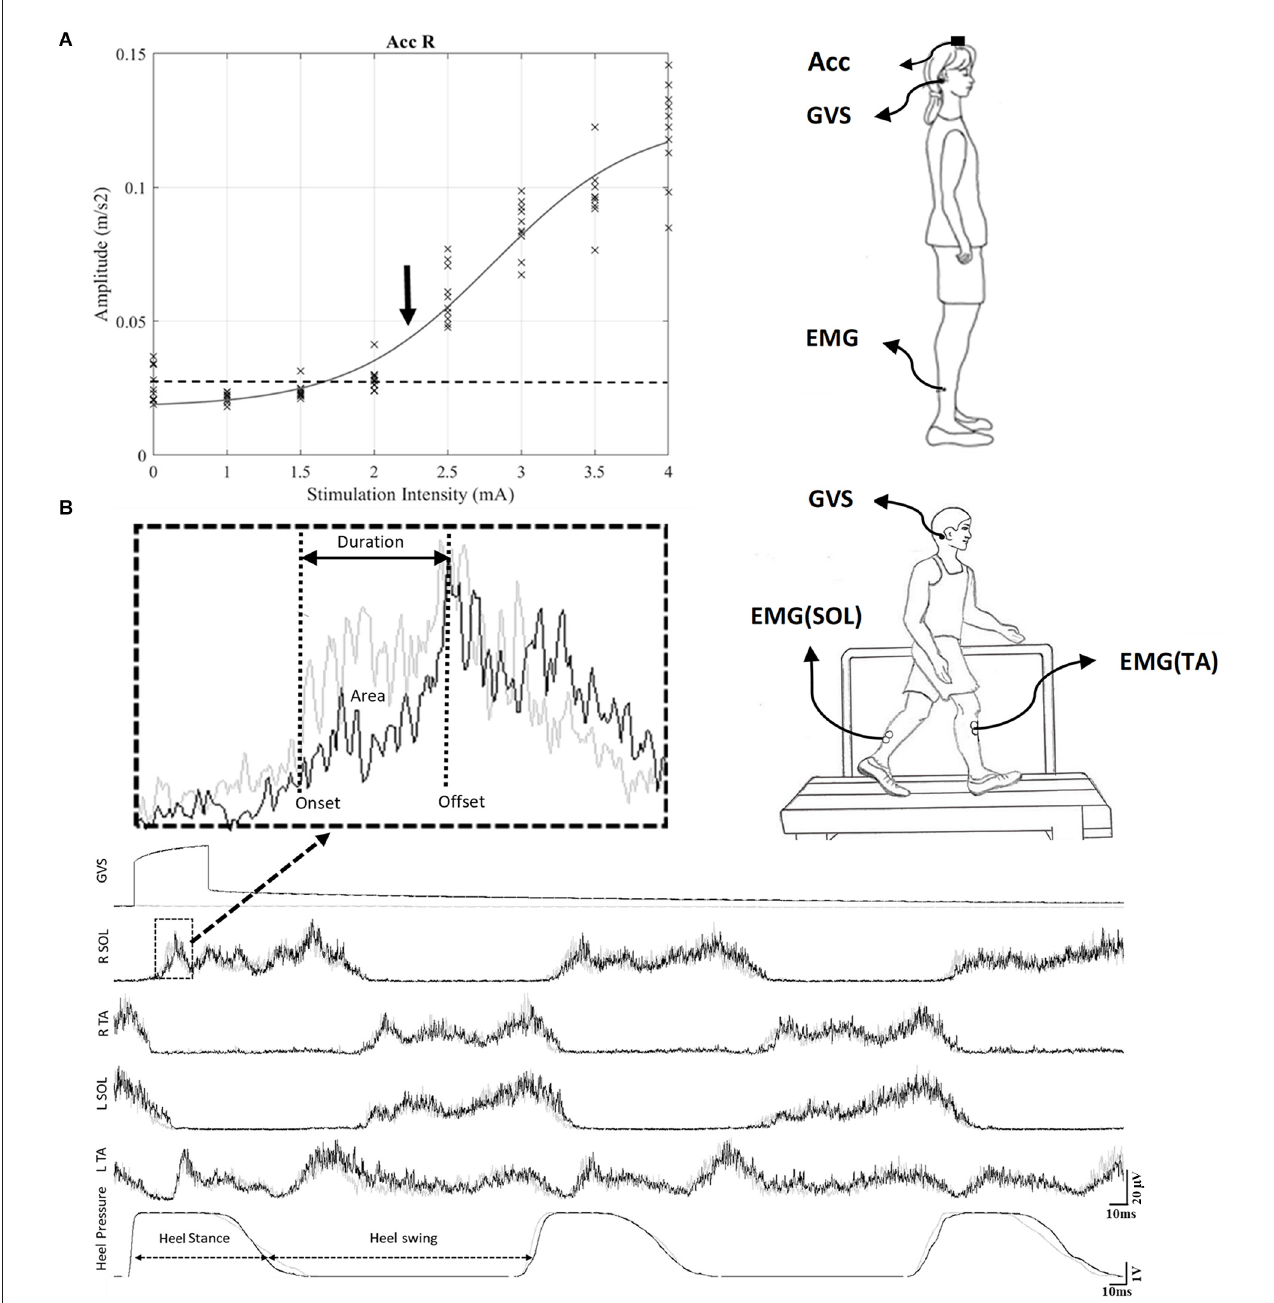
FIGURE1 (A) Recruitment curve set-up during standing. To determine the intensity of stimulation, a recruitment curve was constructed to identify the motor threshold (T) to GVS (see Section “Methods”). The threshold was based on the signal from an accelerometer placed on top of the head (vertex) while subjects were standing with eyes closed. For this representative participant, the threshold was 2.3 mA. (B) GVS during gait on the treadmill set-up: The black trace shows the EMG pattern during the stimulated cycle, and the gray trace shows the EMG pattern during the control cycle. A typical GVS response is shown in the medallion and measures of onset, offset and area are indicated. GVS, galvanic vestibular stimulation; EMG, electromyography.